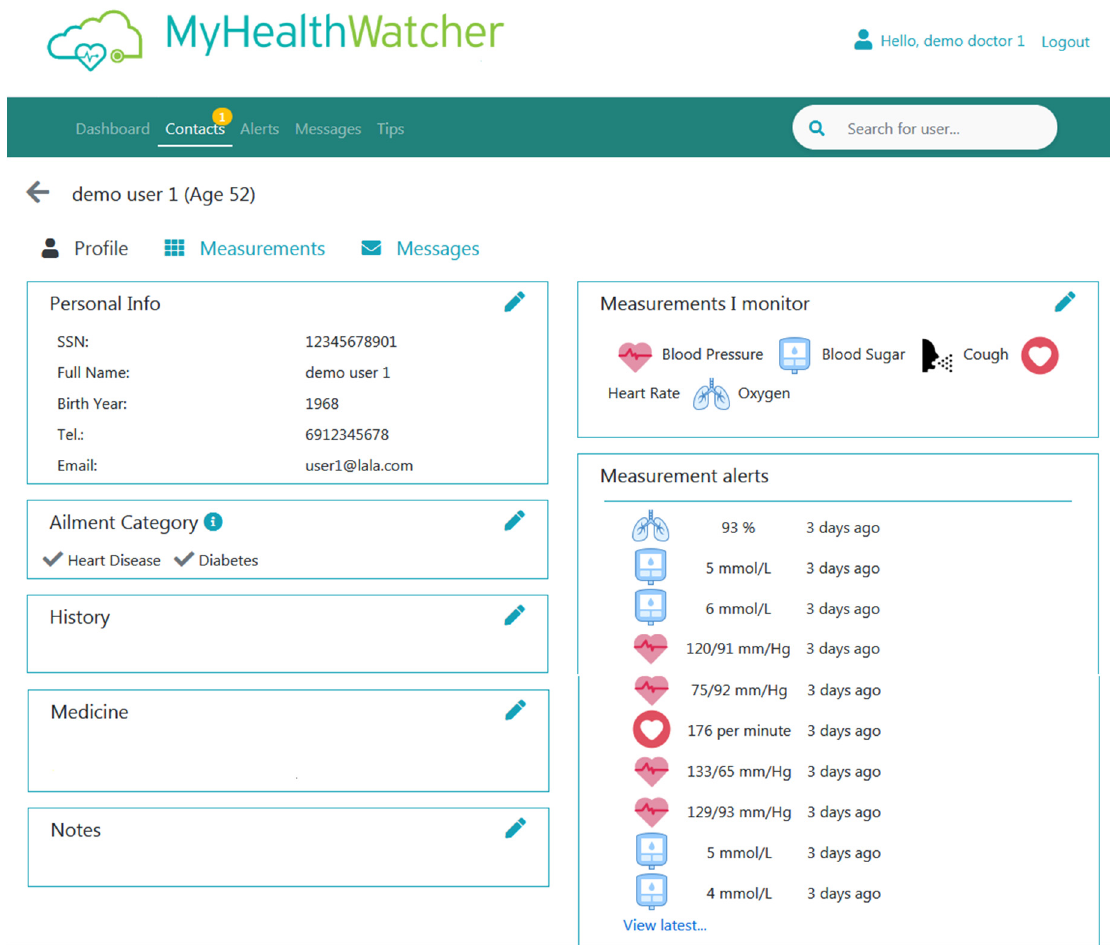
Figure 18. Screenshot of selected patient’s profile view page—current UI implementation.